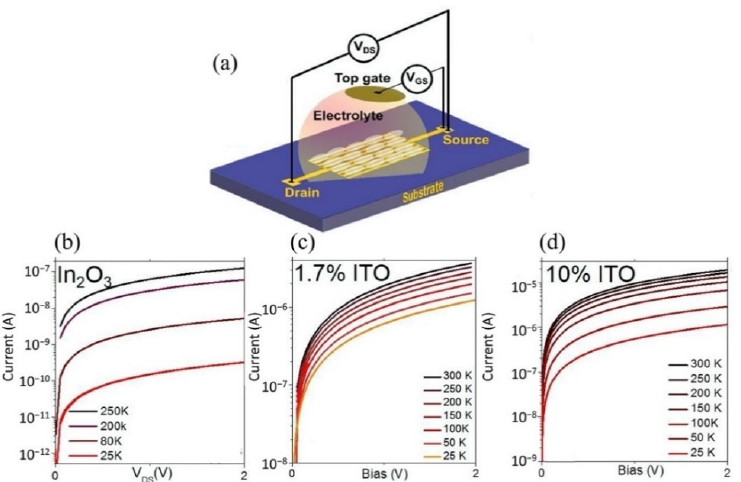
Figure 17. ( a ) Structure of ITO and In2O3 electrolyte gated FET. ( b – d ) FET characteristics of In 2 O 3 and ITO (with 1.7% and 10% of Sn doping) under different temperatures. Reprinted (adapted) with permission from [242]. Copyright 2019 American Chemical Society.